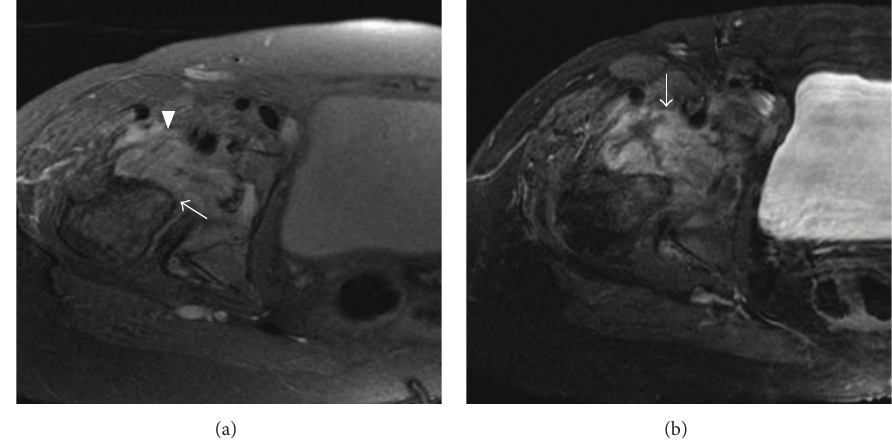
Figure 2: (a) Axial proton density with fat saturation sequence through the right hip joint (a) shows destruction of the femoral head (arrow) and a complex joint effusion (arrowhead). (b) Axial T1 fat saturated sequence after gadolinium reveals synovial thickening and enhancement